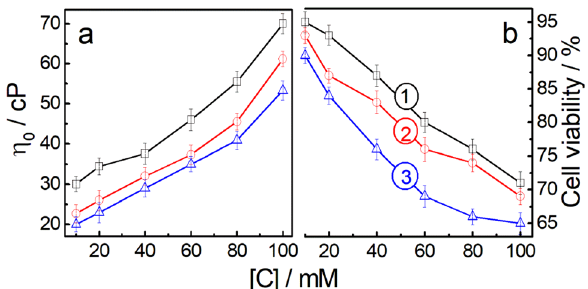
Figure 3. Variation of a, zero shear viscosity and b, human blood lymphocyte cell viability with AASs + HTAB (2/3, M/M) mixed surfactant concentration [C]. Systems: 1, C 12 MalNa 2 + HTAB; 2, C 12 AspNa 2 + HTAB and 3, C 12 GluNa 2 +